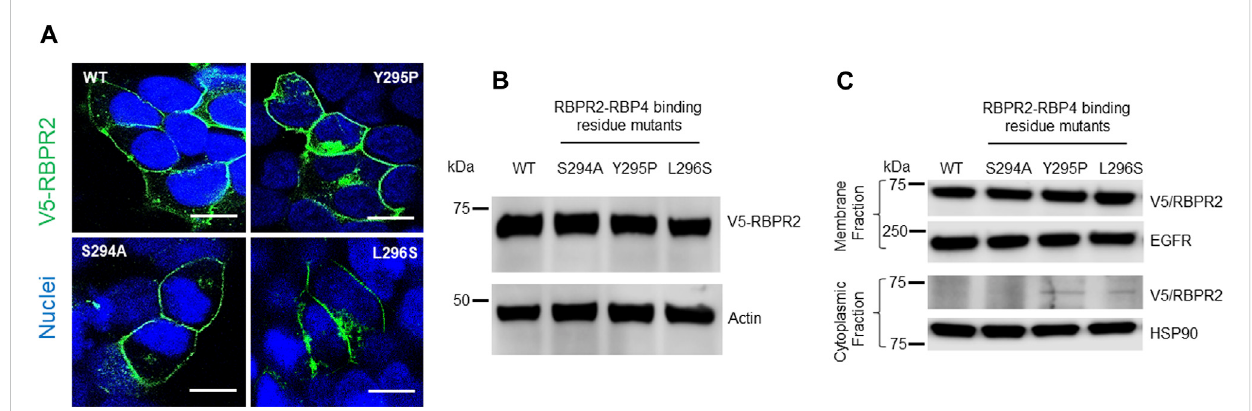
Cellular localization and expression of WT-RBPR2 and RBPR2-mutants. (A) Transient expression and staining of mouse V5-tagged WT-RBPR2 and variants in NIH3T3 cells using the V5-antibody. Nucleus, DAPI, blue; RBPR2-V5, Green. Scale bar = 50 μ m. (B) Protein expression and representative western blot images of WT-RBPR2 and RBPR2-mutant proteins, which affect the “ SYL ” domain; anti-Actin = protein loading control. (C) Subcellular fractionation of stable cells expressing WT-RBPR2 or individual RBPR2-RBP4 mutants. Stable NIH3T3/LRAT cells expressing either WT-RBPR2 or individual RBPR2-RBP4 binding residues mutants were fractionated as outlined in the methods. Normalized portions of each extract (~30 μ g) were analyzed by Western blotting using antibodies against proteins from cytoplasmic (HSP90) and plasma membrane (EGFR).